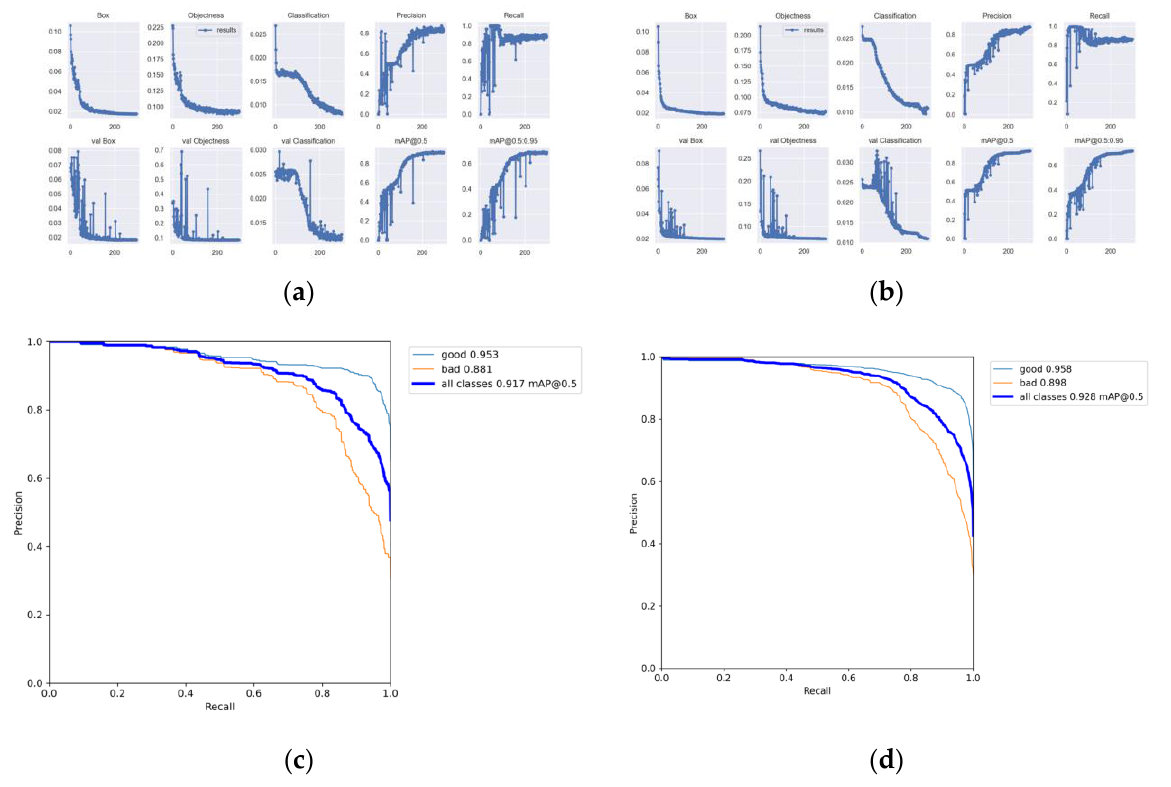
Figure 9. YOLOv5s training results. ( a )YOLOv5s network training results; ( b )YOLOv5s Network Training Results After Data Enhancement; ( c )YOLOv5s PR curve; ( d )YOLOv5s PR curve after data enhancement.